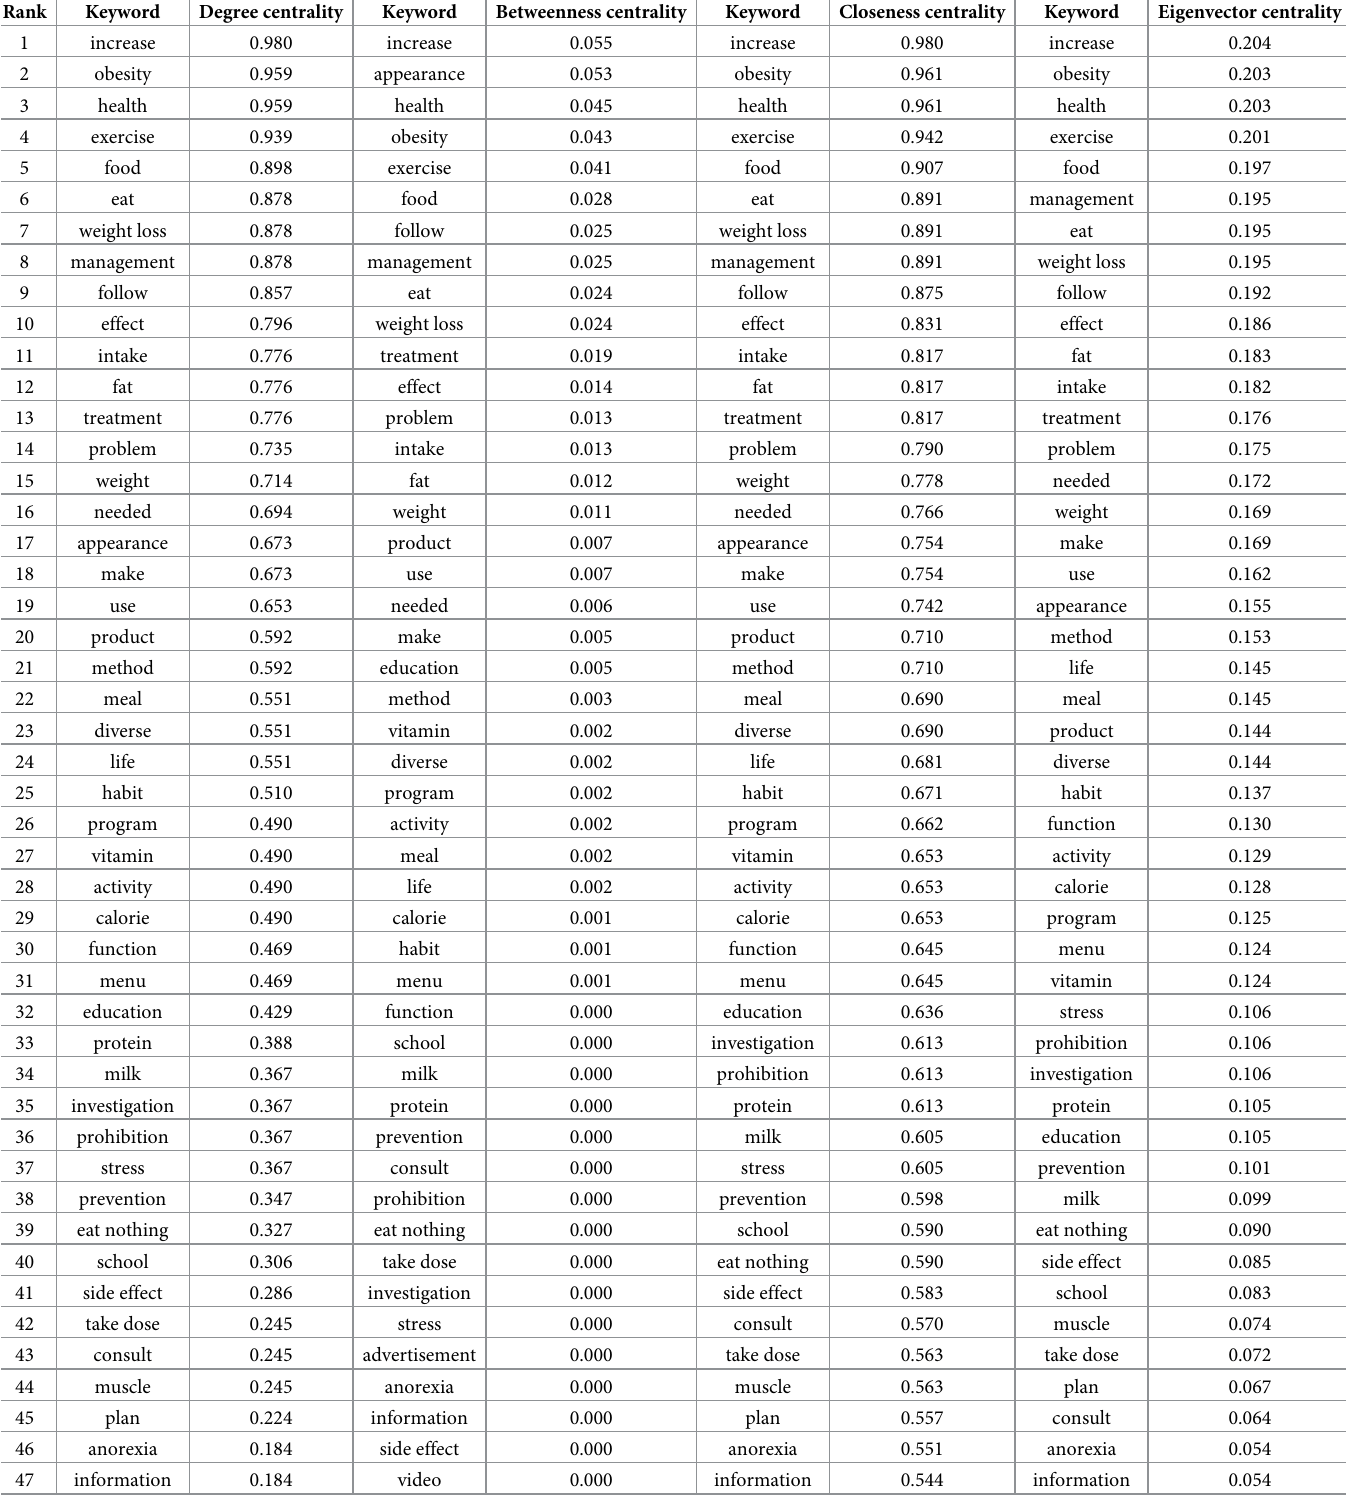
Table 3. Centralities of keywords related to adolescents’ diets from News